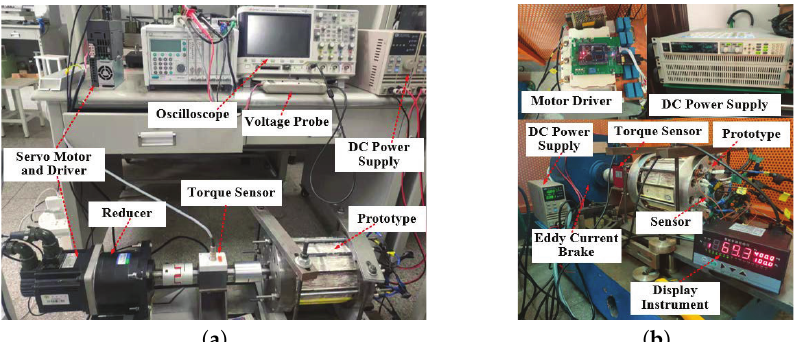
Figure 11. Different end caps and measured phase inductance. ( a ) End caps. ( b ) Measured phase in- ductance.